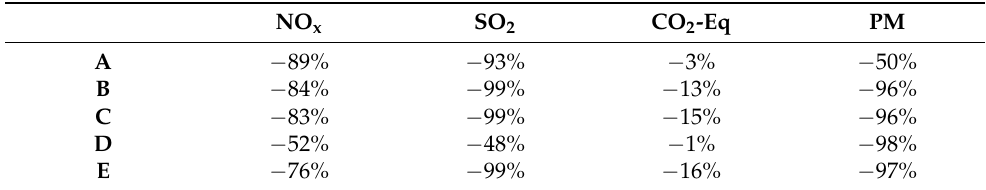
Table 12. Emissions reduction between scenarios 1 and 2.